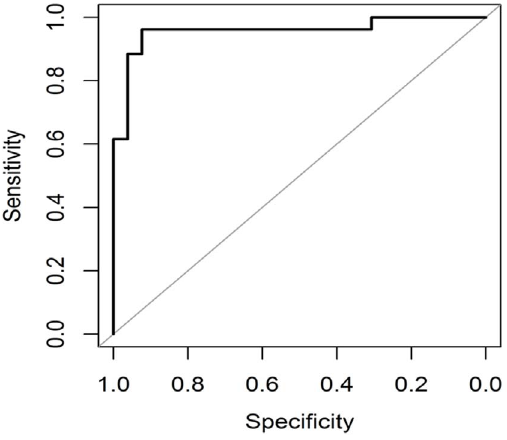
Figure 7. ROC plot for classification between TB and non-TB CXRs (DA) using Gist features.